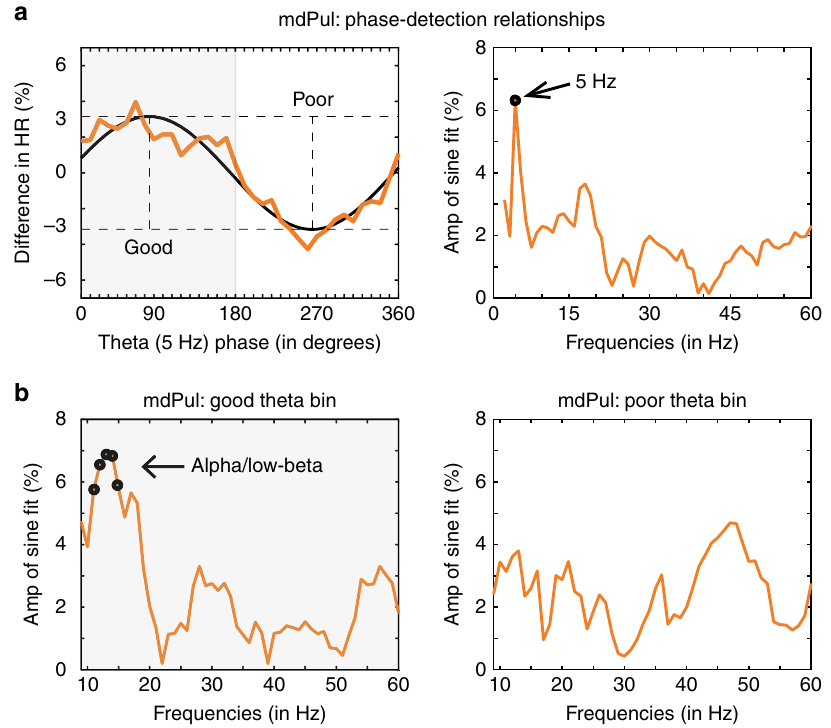
Fig. 4 The phase of low-frequency oscillatory activity in mdPul is linked to behavioral performance. Hit rates (HRs) were calculated (across recording sessions, N = 95) as a function of oscillatory phase when response fi elds overlapped the cued location. a Phase-detection functions were then fi t with one- cycle sine waves (left), with the amplitude of that sine wave representing the strength of the relationship between visual-target detection and oscillatory phase. These phase-detection relationships were calculated at different frequencies, from 3 to 60 Hz (right). Phase-detection relationships at higher frequencies (in FEF and LIP) were previously shown to be dependent on the phase of theta-band rhythms 4 . b Phase-detection relationships in mdPul were therefore re-calculated after fi rst binning trials into two theta-phase bins: (i) one centered on the theta phase associated with better visual-target detection (i.e., the “ good ” bin) and (ii) one centered on the theta phase associated with worse visual-target detection (i.e., the “ poor ” bin). The black dots represent statistically signi fi cant results after corrections for multiple